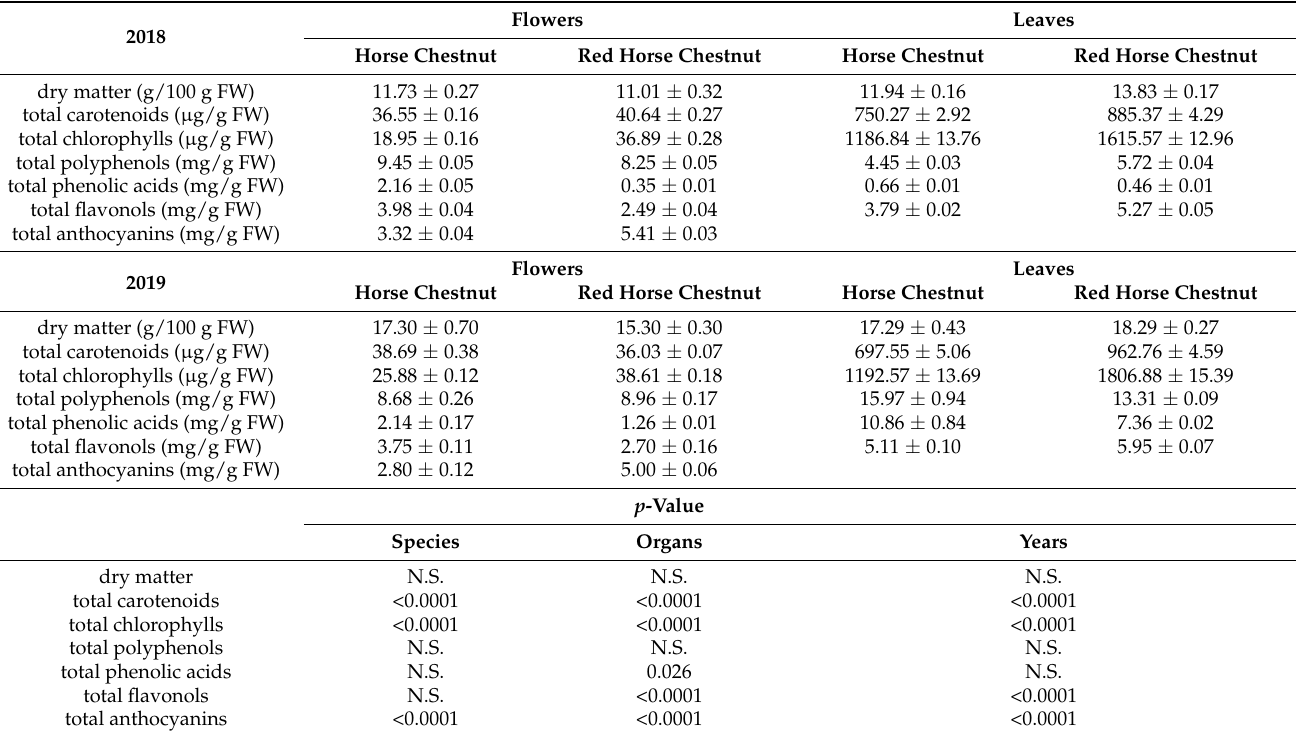
Table 1. The content of bioactive compounds in total in flowers and leaves of horse chestnut and red horse chestnut ( ± standard error). N.S (statistically not